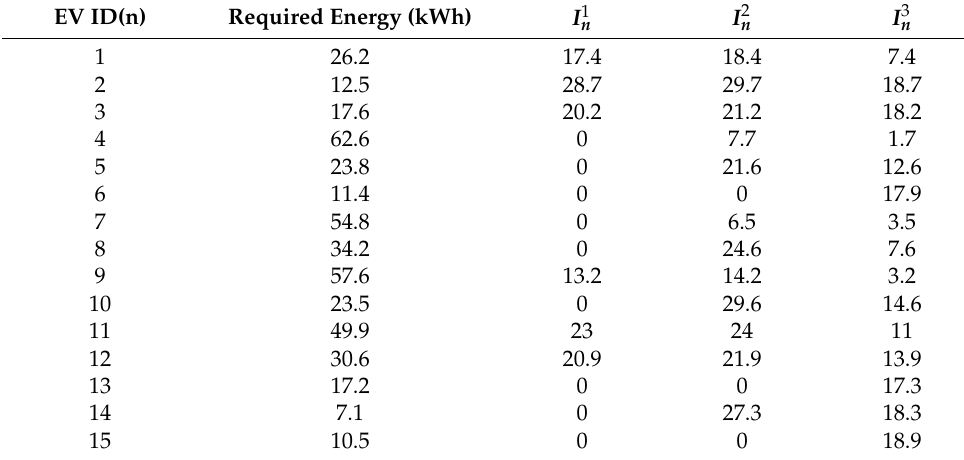
Table 1. EV-wise rank and required energy